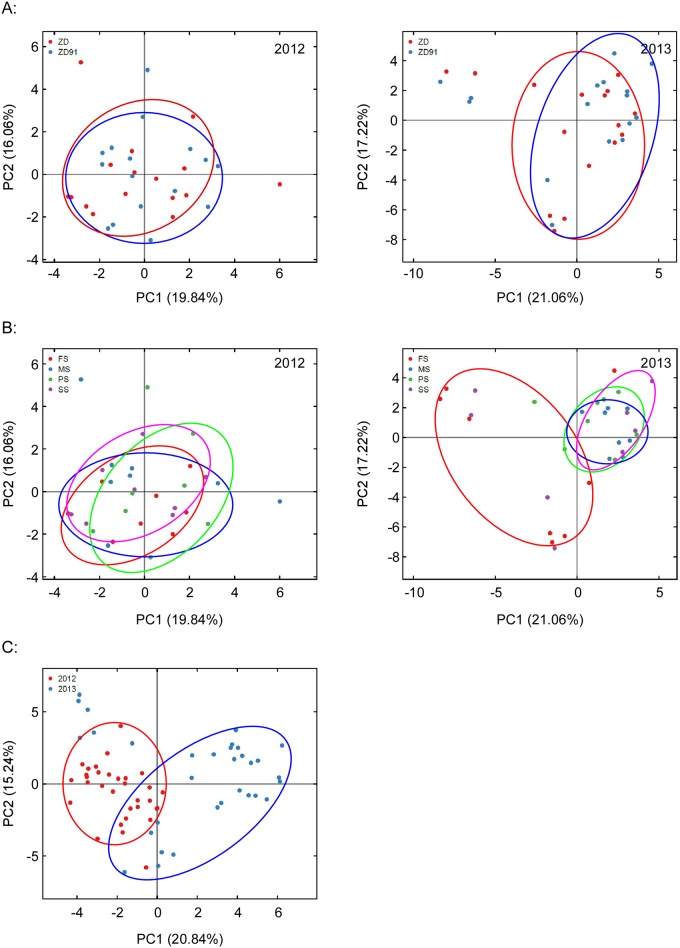
PCA of AMF community structure based on OTUs at a distance of 3% for individual samples.A: AMF community structure between cultivars. B: AMF community structure between growth stages. C: AMF community structure between years. The eigenvalues displayed on the diagram axes refer to the percentage variation of the respective axis. SS: seedling stage; FS: flowering stage; PS: pod-setting stage; MS: maturity-setting stage.